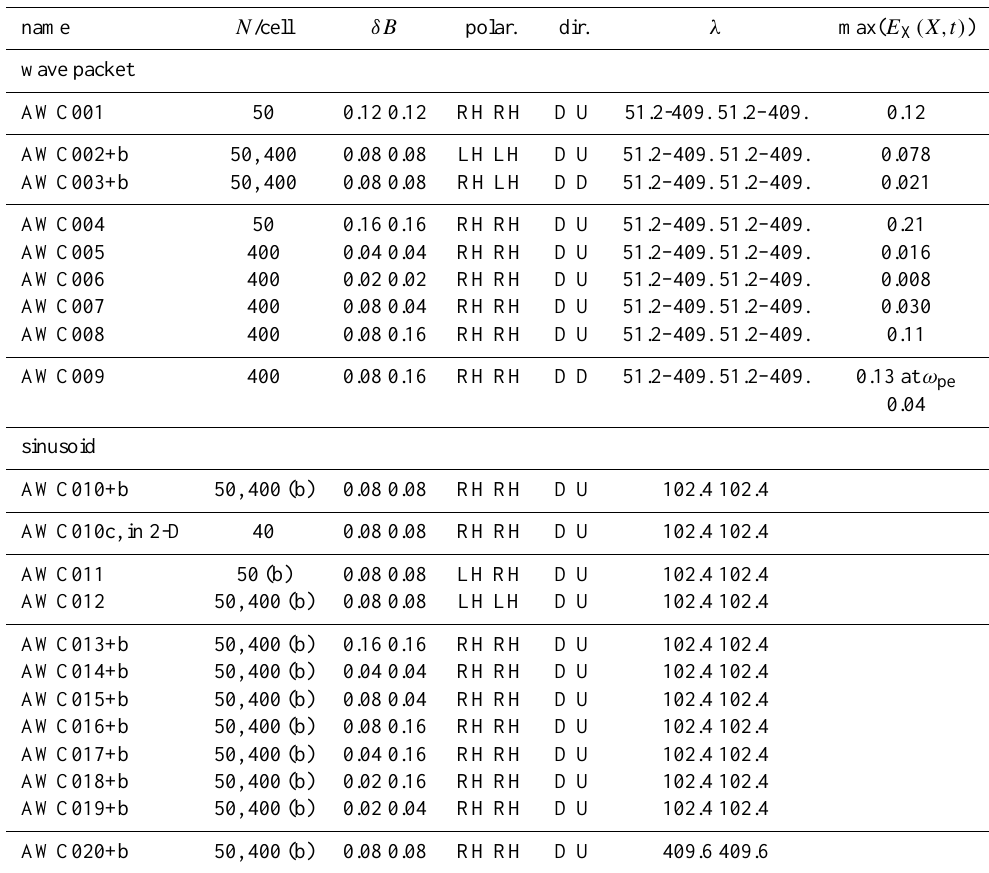
Table 1. Simulation parameters varied from AWC001, and parallel electric field maximum value. Each column contains the data for the wave packets 1 and 2. RH (resp. LH) is for right-hand (resp. left-hand) polarized waves. D and U mean Downward and Upward propagation. The simulations AWC001 to AWC009 correspond to wave packets, each packet being the sum of 8 sinusoidal waves with the same amplitude. This amplitude, given in the column δB , can be different for the two wave packets. The range of wavelengths is indicated in the column λ . In the simulation AWC010-AWC019, there are no wave packets, but only two sinusoidal waves, whose wavelengths are given in the column λ . Versions “b” are made with more particles. Version “c” is a 2-D simulation (see text). In the last column is displayed the maximum amplitude of the parallel electric field at any place and any time in the simulation. The maximum intensity is reached at the locus of the wave packets interactions, except for AWC009, where the most intense value of E X is associated to plasma wave oscillations. For AWC009, the second number indicates the amplitude associated with the Alfv´en waves